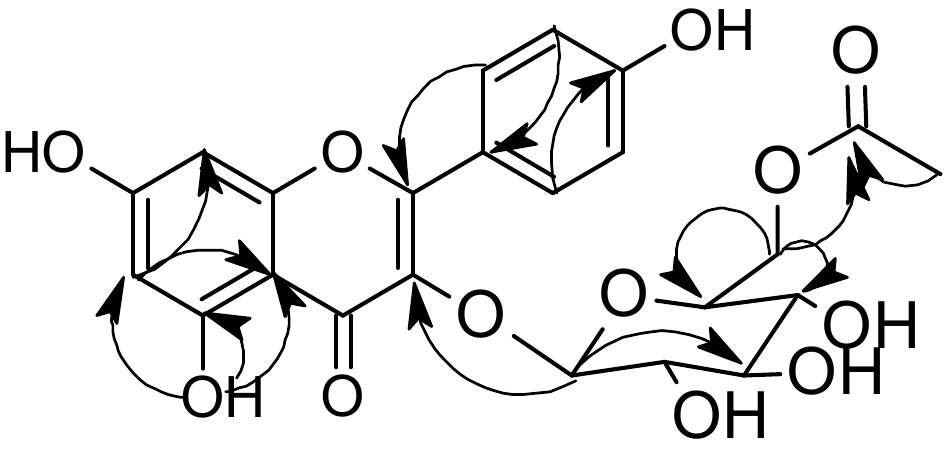
Figure 2. Main HMBC relations of K3G-A .